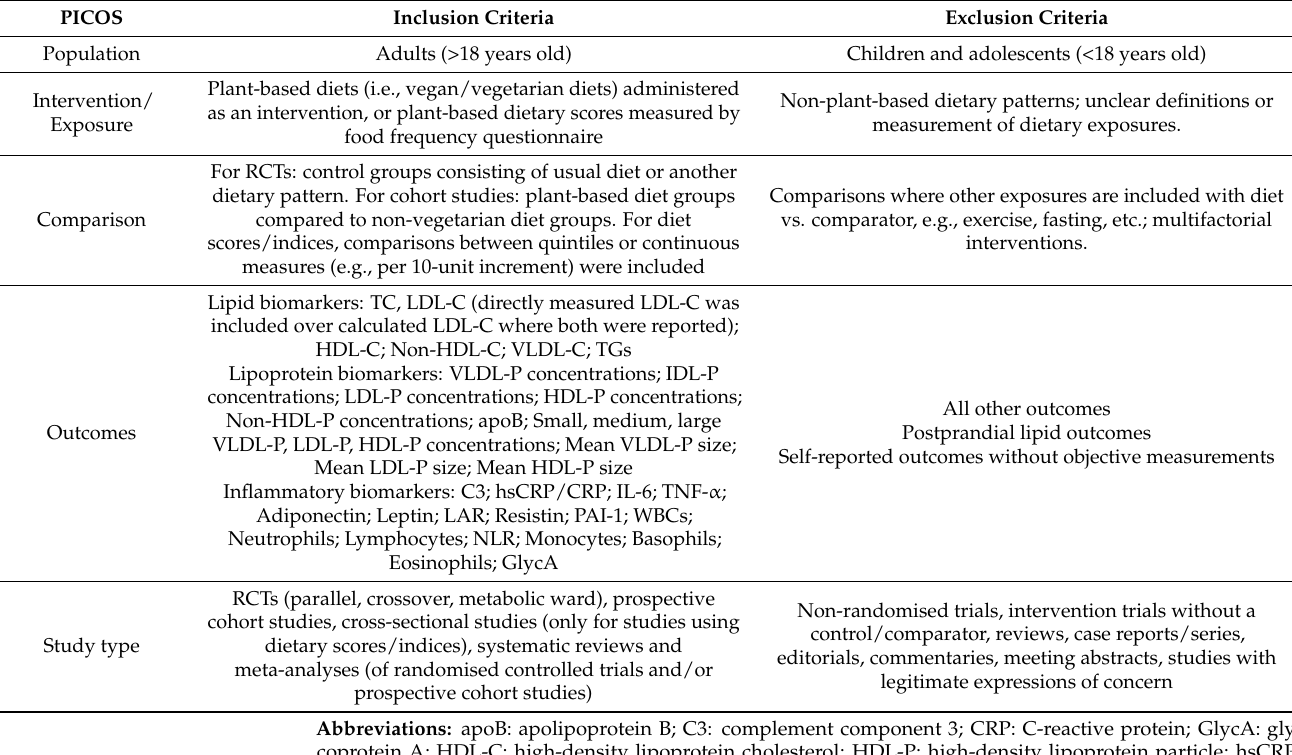
Table 1. Eligibility Criteria.